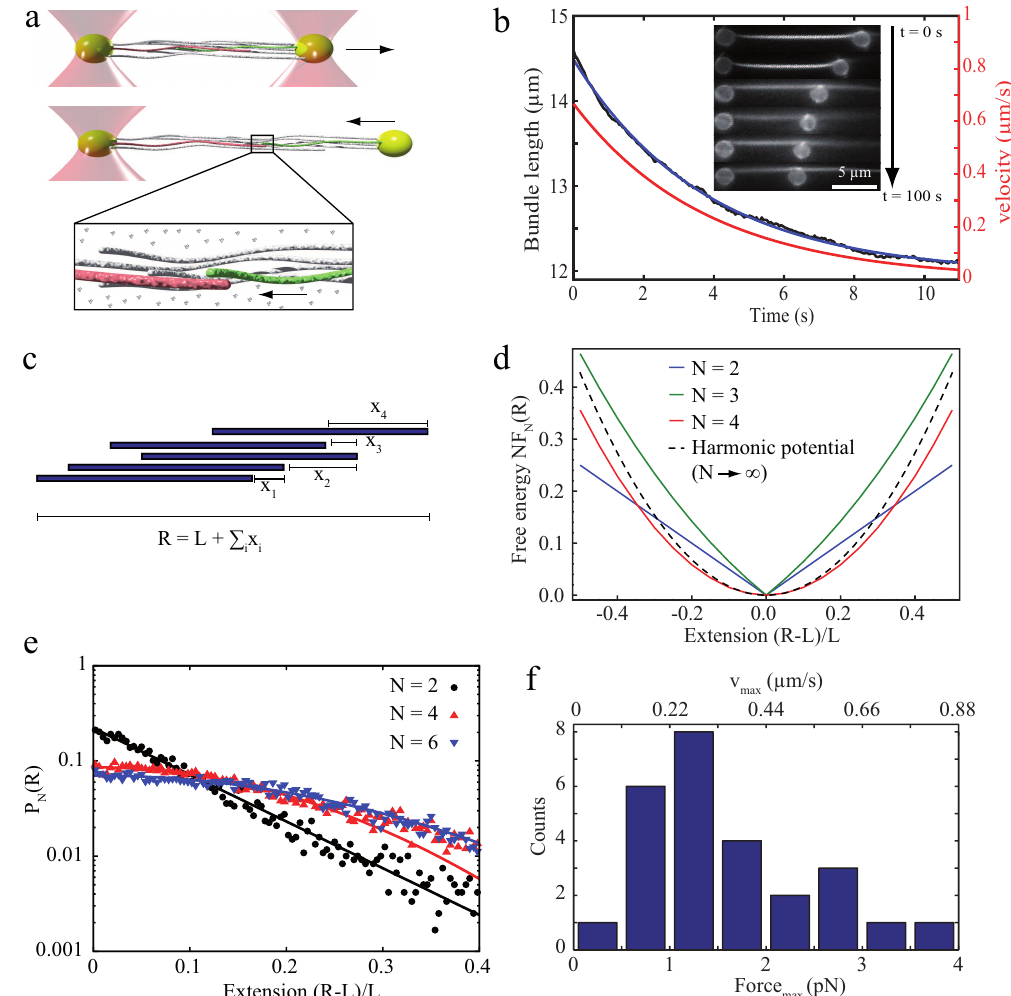
Figure 3. ( a ) Bundles formed by depletion forces can be deflected from their energetic minimum by inducing pulling forces via optical tweezers. After switching off the external force, bundles contract to restore the maximal overlap of excluded volumes; ( b ) recorded bundle lengths over time during contraction processes (inset) can be well described by an exponential decay function. This fitting function can be differentiated allowing an evaluation of the contraction velocity ( red graph); ( c ) the exponential decay can be described within a mathematical model in an idealized 2D-scenario, where forces are applied at the first ( i = 1) and at the last filament ( i = N ), with L being the uniform filament length, R the length of the stretched bundle, and x i the displacement between filaments; ( d ) plotting the free energies F N ( R ) vs. the extension R − L shows a strong dependency on the filament number N . A two-filament bundle ( N = 2) has a linear energy landscape [37–40], but with only a few filaments ( N = 4) the asymptotic, harmonic form (dashed) is nearly reached [17]; ( e ) the transition from a linear to a harmonic potential shape was further confirmed by simulations. A two-filament bundle follows an exponential probability distribution as given by the Boltzmann weight. Bundles formed by six filaments yield a Gaussian probability distribution corresponding to a harmonic potential; and ( f ) measured maximal forces compare well to forces exerted by single myosin motors [2]. The figure is adapted from Schnauß et al.